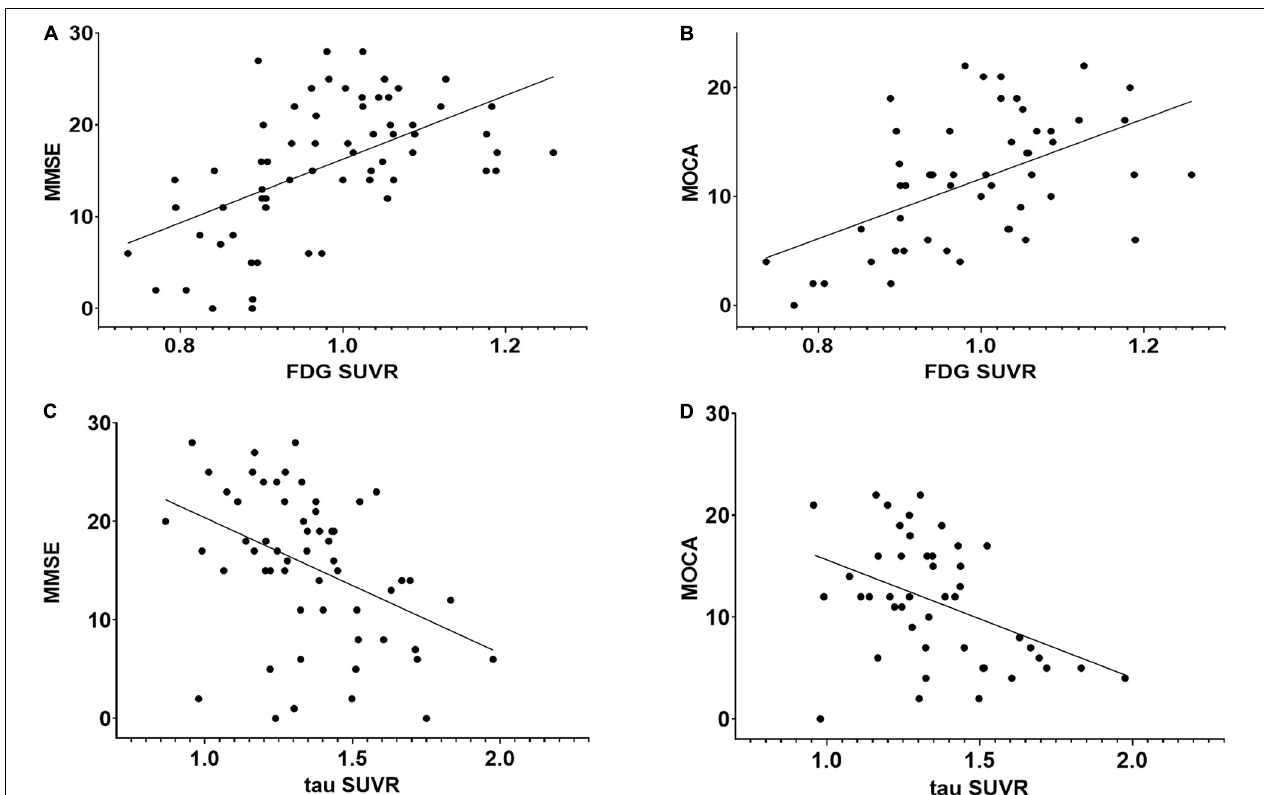
FIGURE 4 | Regression plots representing the relationship between neuropsychological scores and FDG or tau PET SUVR in the whole cortex. (A) Relationship between MMSE and FDG SUVR ( r = 0.557, p < 0.01). (B) Relationship between MOCA and FDG SUVR ( r = 0.501, p < 0.01). (C) Relationship between MMSE and tau SUVR ( r = –0.411, p < 0.01). (D) Relationship between MOCA and tau SUVR ( r = –0.402, p < 0.01). There was no significant correlation between tau PET and FDG PET